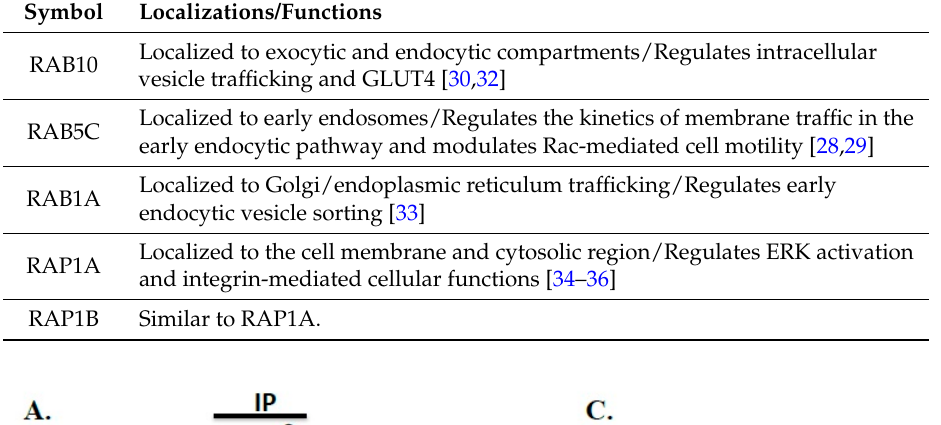
Table 1. Identification of possible interactors of MGCRABGAP through coimmunoprecipitation (co-IP)